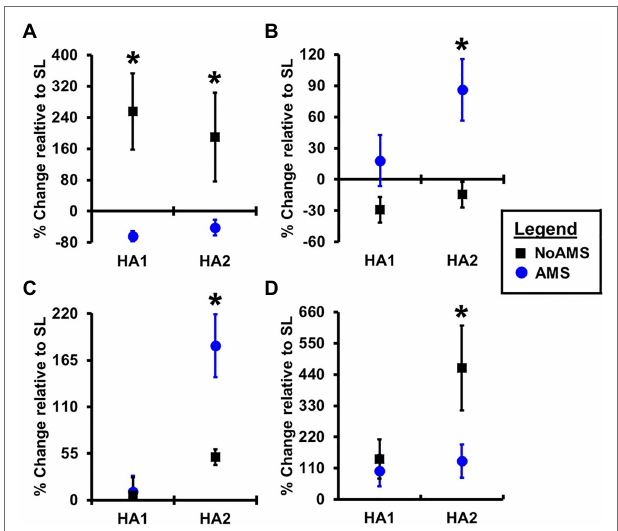
FIGURE 4 | Urinary creatine levels for AMS susceptible (blue symbol) and NoAMS resistant subjects (black symbol) at SL, and 4,300 m on day 1 (HA1) and day 18 (HA2) determined using the (A) 1 H NMR technique and (B) creatine assay. Asterisk denotes significant difference between groups ( p ≤